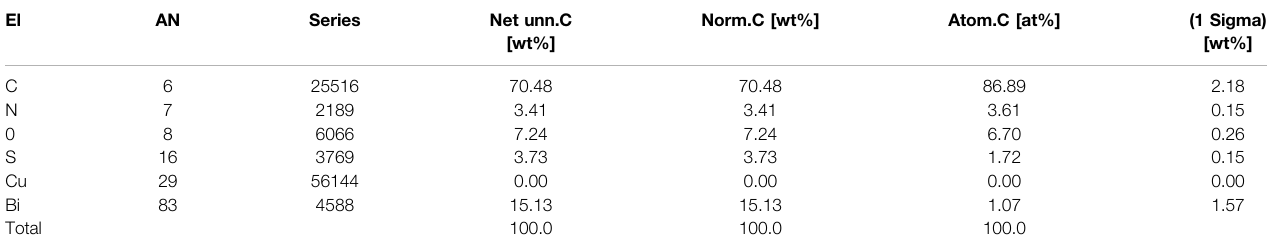
TABLE 1 | Composition of elements in bismuth – sulfur nanoparticles identi fi ed using energy-dispersive X-ray spectrometry (EDS). El AN Series Net unn.C